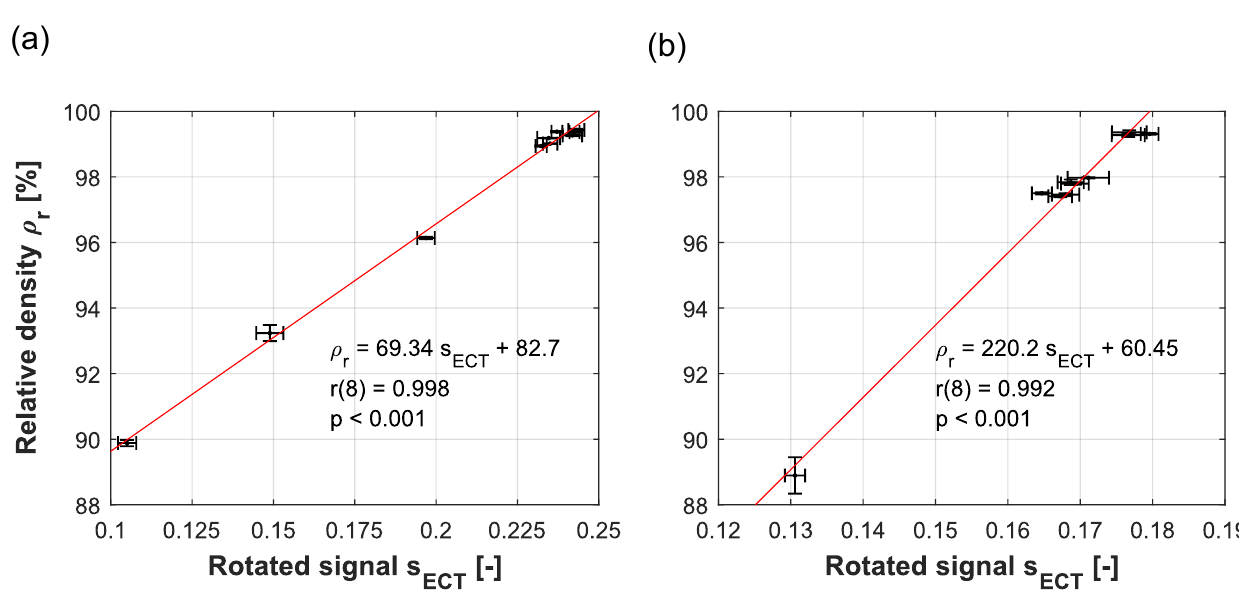
Figure 6. ( a ) Correlation of the rotated signal and the relative part density of 316L parts. ( b ) Correlation of the rotated signal and the relative part density of AlSi10Mg parts. The ECT data presented is extracted from a 2 × 5-mm 2 (X × Y) region in the center of each part to exclude the edge effect. The error bars depict the standard deviation of the rotated signal across the extracted area (horizontal) and the standard deviation of three density measurements per part (vertical). The curve was fitted to the given data via the least squares